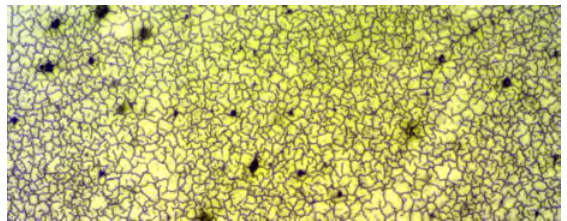
Figure 20. Microscopic view on an evaporated as well as photolithographically processed Chromium electrode on a 20µm thick PET substrate.